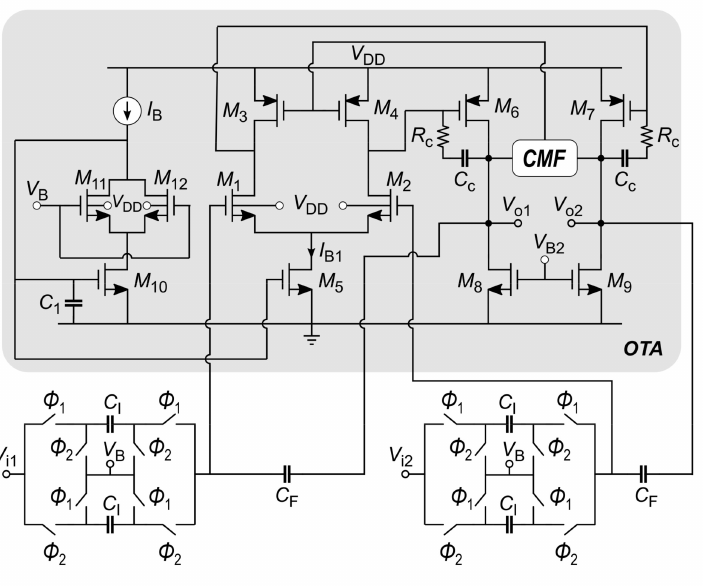
Figure 4. Schematic of a differential inverting SC